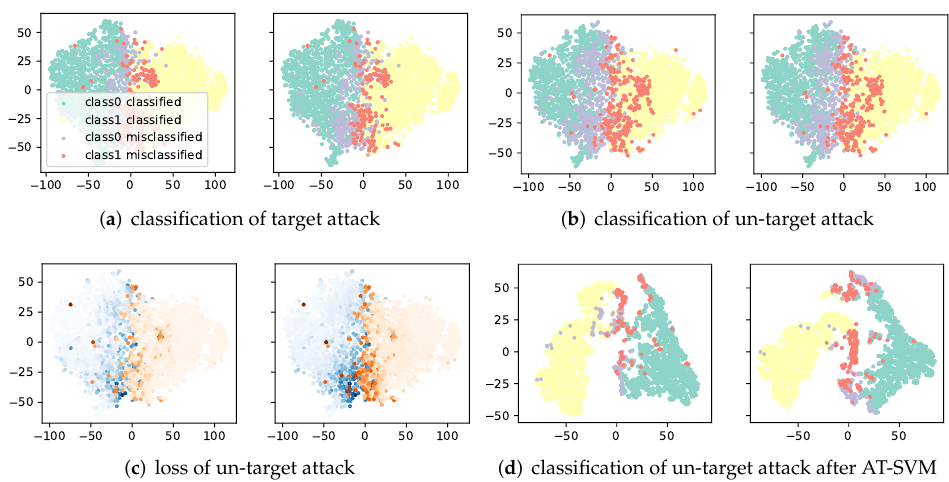
Figure 1. Two-dimensional visualizations of the model’s output distribution of natural examples and adversarial examples from two separated classes from the CIFAR-10 dataset. For each subfigure, the left channel indicates the result from the original model and the right channel indicates the result from the SVM auxiliary classifier. First, we train the original model using SAT. Then we insert our SVM auxiliary classifier and train it but with the original model fixed. The classifying results are shown in ( a , b ). The loss of them is shown in ( c ). Last, we use our AT-SVM to train a model, the result is shown in ( d